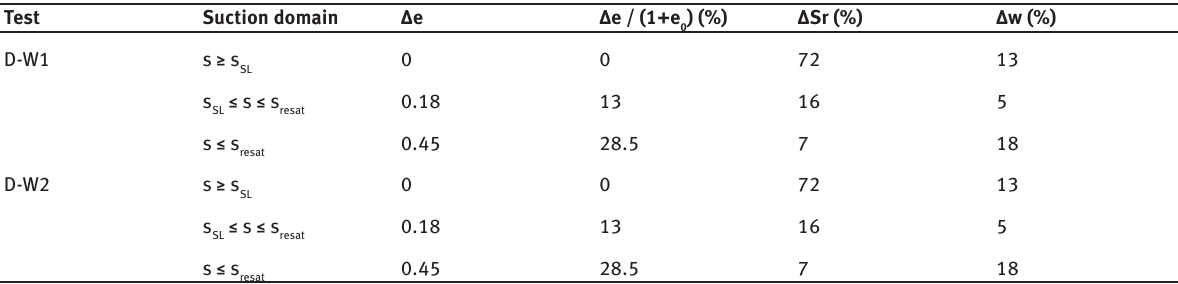
Table 7: Variation of the state parameters as a function of suction domain on wetting path. Test